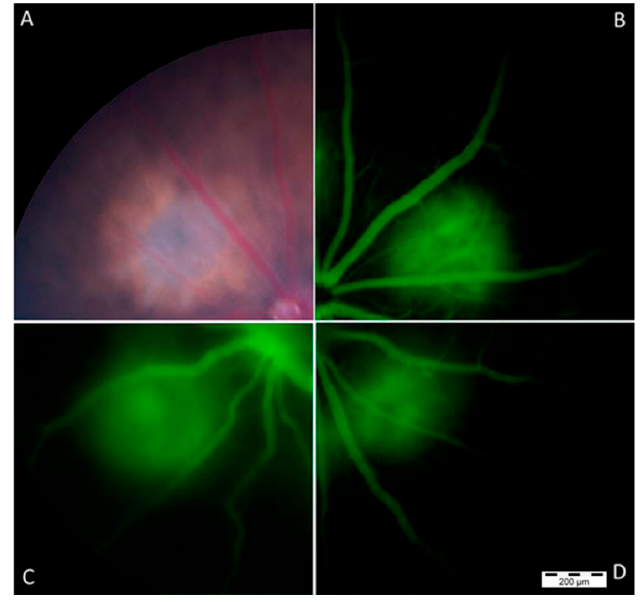
Figure 8. Representative fundus images of the mouse retina were taken after laser treatment: ( A ) a representative color fundus image of the mouse after laser-induced CNV treatment; ( B ) fluorescein angiography (FFA) of CNV lesion of mouse receiving CNV generation only; ( C ) FFA of mouse receiving CNV-generating laser treatment and miR-control ; and ( D ) FFA of mouse receiving CNV-generating laser treatment and miR-126 mimic . Scale bar = 200 μ m